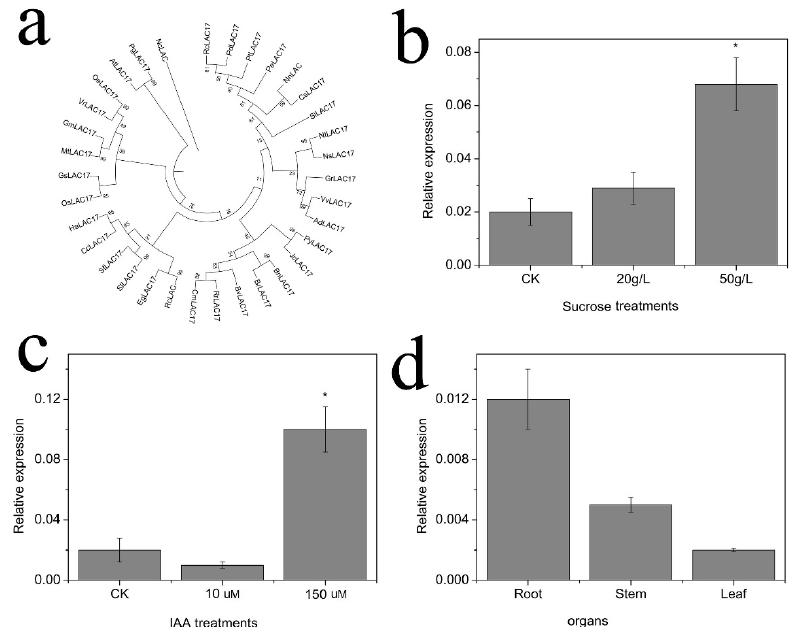
Figure 5. Cloning and expression analysis of NnLAC17 in lotus seedlings. ( a ) Analysis of the similarity between NnLAC17 and that of other species. ( b ) Relative expression of NnLAC17 in seedlings treated with 20 g/L and 50 g/L sucrose. ( c ) Relative expression of NnLAC17 in seedlings treated with 10 μ M and 150 μ M IAA. ( d ) Relative expression of NnLAC17 in different organs of lotuses. (“*” represents significant different at 0.05 level, p < 0.05.)